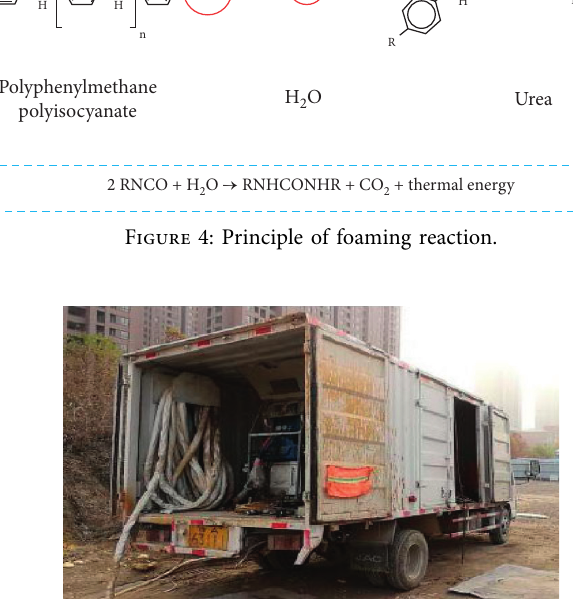
Figure 5: Vehicle-mounted polymer grouting integrated